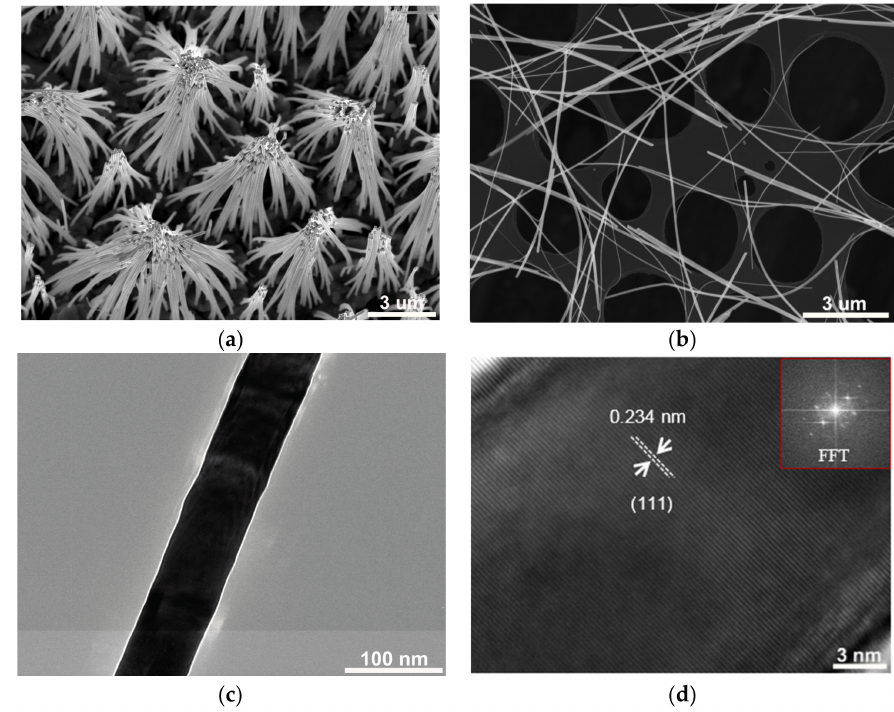
Figure 1. Scanning electron microscopy (SEM) images of gold nanowires (NWs) ( a ) Prepared on Au/Cu substrate; ( b ) Transferred to transmission electron microscopy (TEM) grid; ( c ) TEM image of 70 nm gold NW; ( d ) High resolution TEM image of gold NW which indicates growing direction of [111]. The diameter is 30 nm and the inset is the fast Fourier transform (FFT) image of this